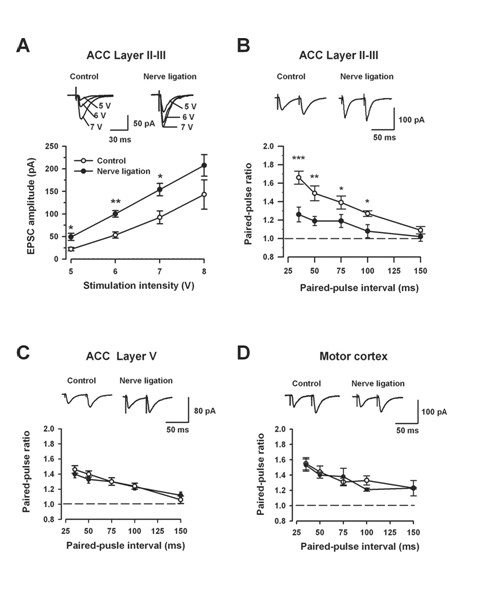
Increased synaptic transmission in layer II/III in the ACC after peripheral nerve ligation. A, Synaptic input-output curves in slices from control (n = 6 neurons) and nerve-ligated (n = 7 neurons) mice. *p < 0.05 and **p < 0.01 compared with those of control group. Open circles, Neurons from control mice; filled circles, neurons from mice with nerve ligation. B, Representative traces with an interval of 50 ms recorded in layer II/III of the ACC. Paired-pulse ratio (the ratio of EPSC2/EPSC1) was recorded at intervals of 35, 50, 75, 100, and 150 ms from control and nerve-ligated mice. Open circles, Neurons from control mice (n = 17 neurons); filled circles, neurons from mice with nerve ligation (n = 19 neurons). *p < 0.05; **p < 0.01; ***p < 0.001. C, PPF in layer V of the ACC from control and nerve-ligated mice. Open circles, Neurons from control mice (n = 9 neurons); filled circles, neurons from mice with nerve ligation (n = 15 neurons). D, PPF in motor cortex neurons from control and nerve-ligated mice. Open circles, Neurons from control mice (n = 5 neurons); filled circles, neurons from mice with nerve ligation (n = 5 neurons) (from reference 31).